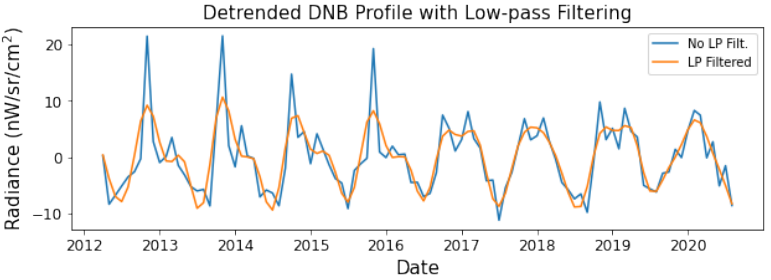
Figure 9. Low-pass filtering applied on the detrended VNL monthly